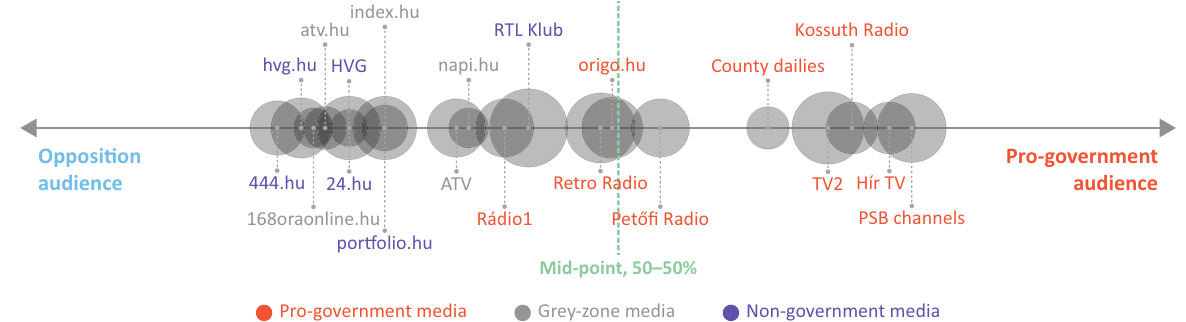
Figure 3. Audience composition by party preference of the top 20 most regularly consumed media. Notes: The position on the axis shows the proportion of the given media’s audience that is pro‐government or opposition; the size of the bubble depends on the number of its regular